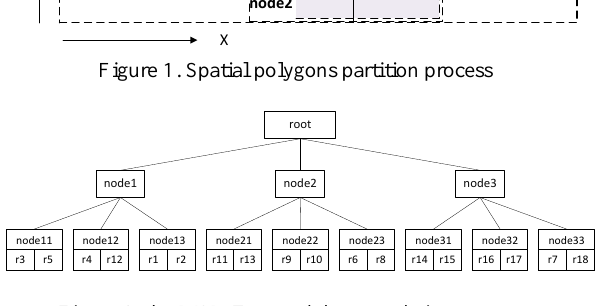
Figure 2. the DKD Tree and the records it represents As it is shown in figure 1, rectangles marked from r1 to r18 with grey background color are MBRs of 18 spatial polygons.